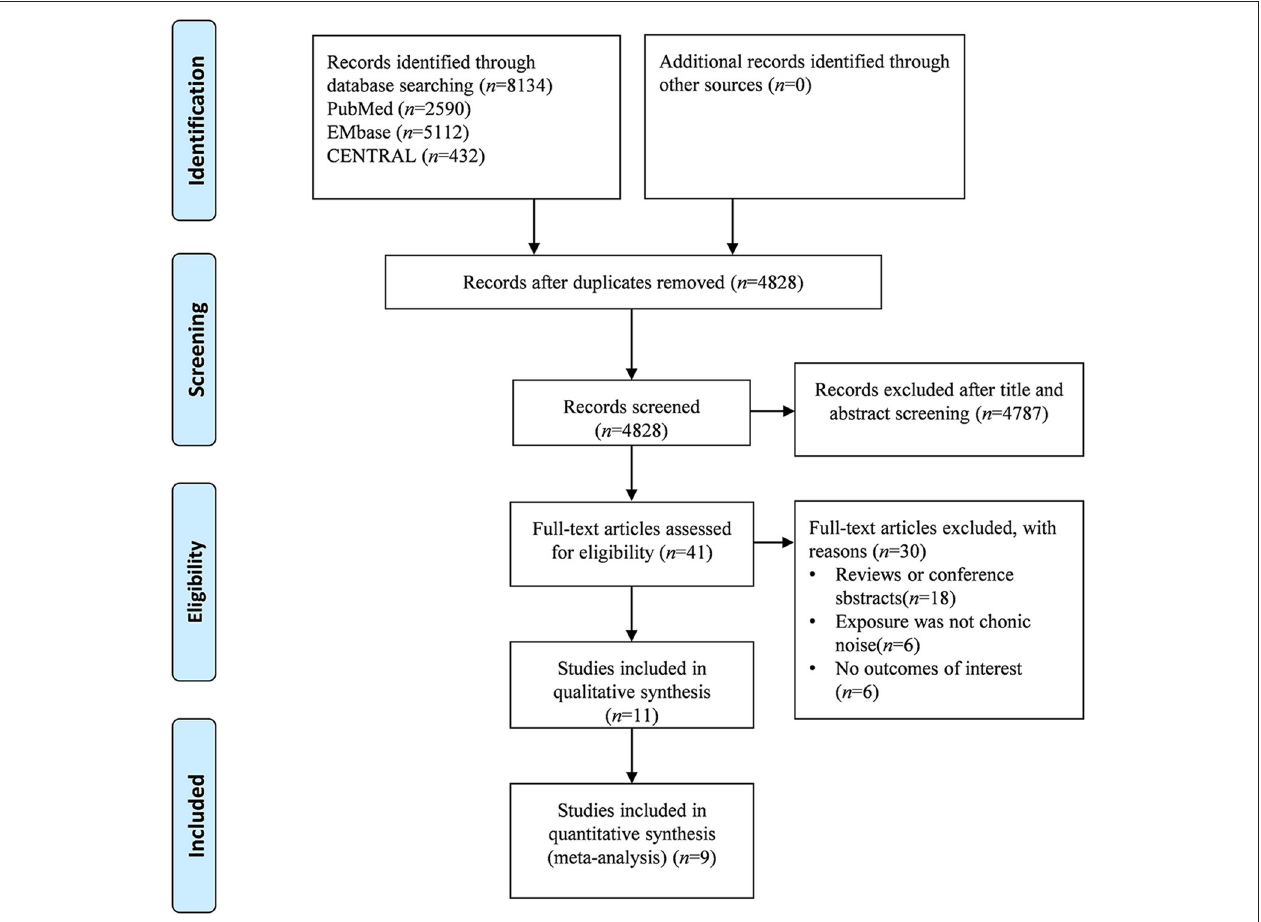
FIGURE 1 | Flowchart of literature